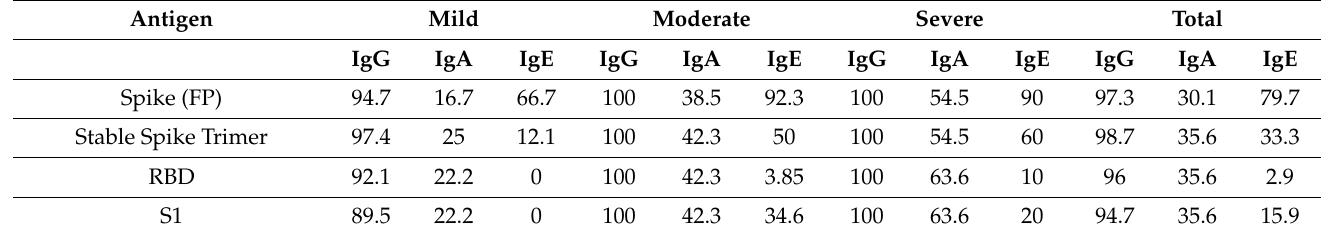
Table 2. Frequency of Individual Serological Response During SARS-CoV-2 Infection (%) [127]. Copyright permission refer to citations and/or Supplementary Data.